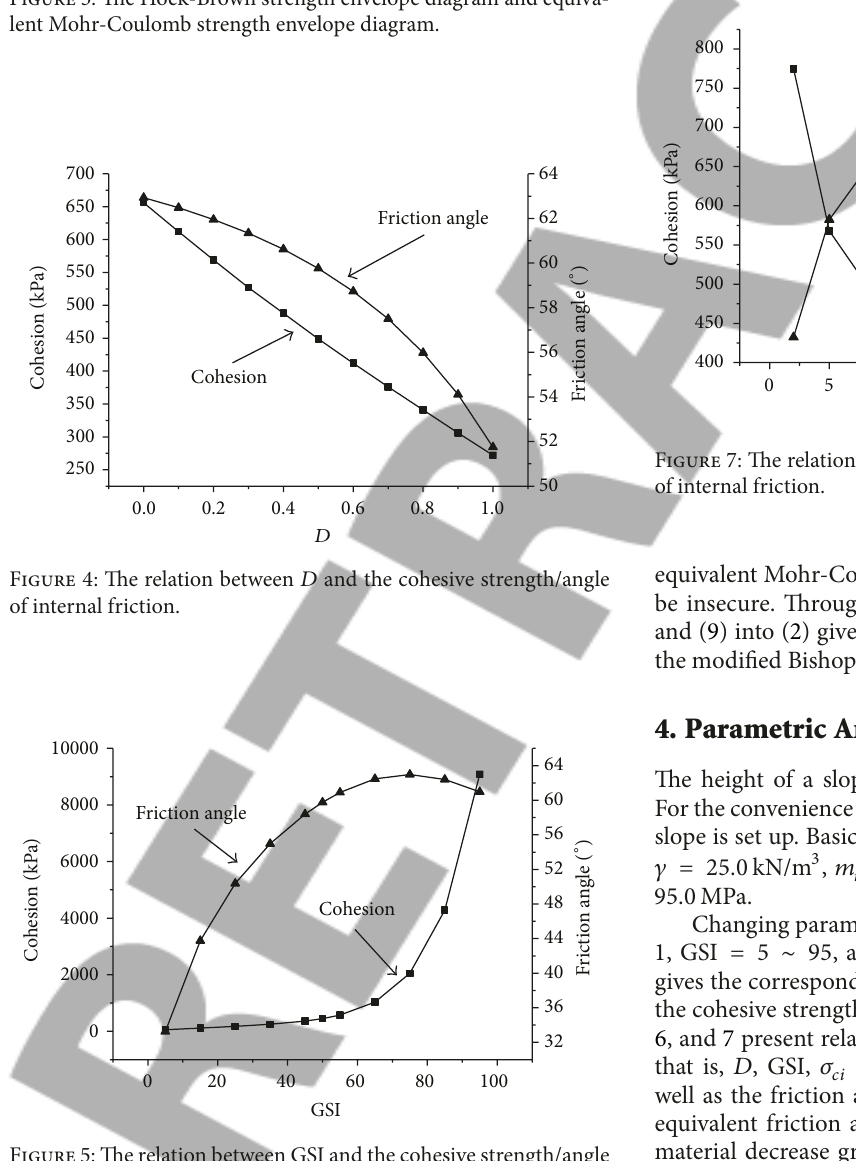
Figure 5: The relation between GSI and the cohesive strength/angle of internal friction.